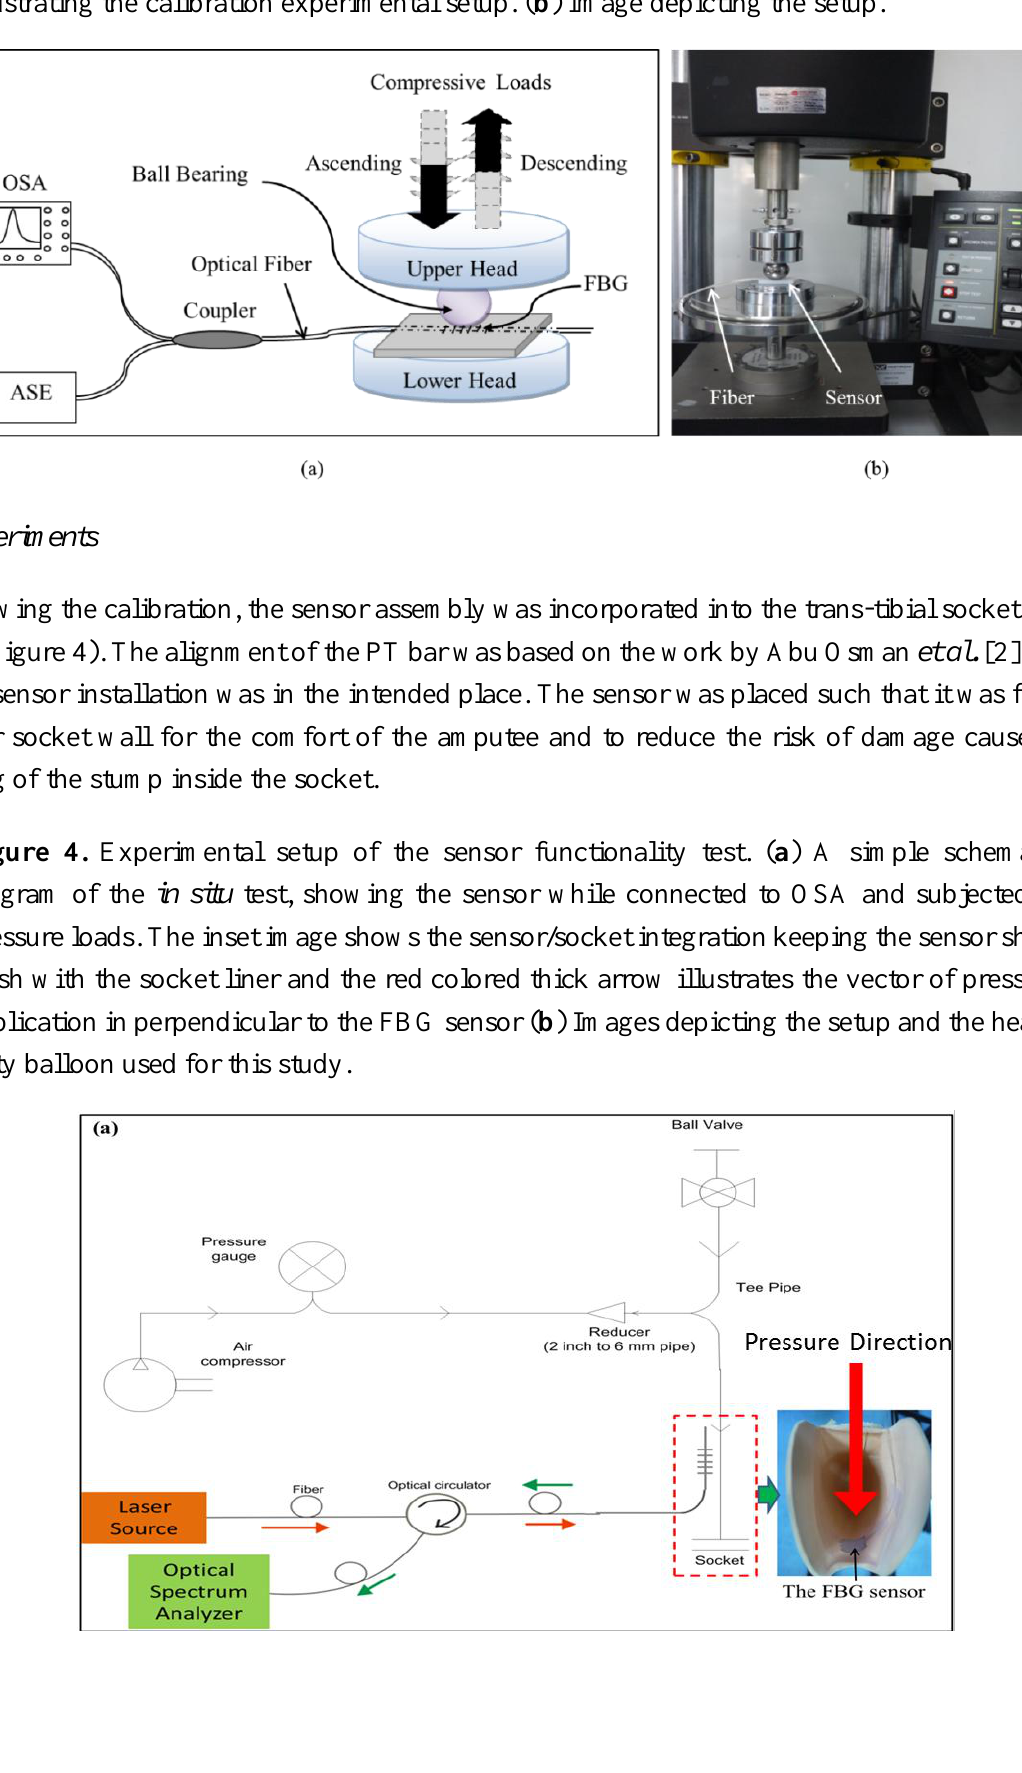
Figure 3. Schematic diagrams of the sensor calibration. ( a ) Simple schematic diagram illustrating the calibration experimental setup. ( b ) Image depicting the